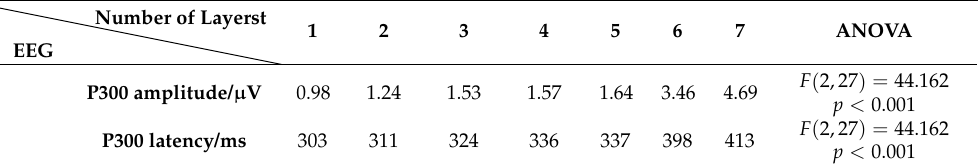
Figure 16. Change trend graph of subjects' eye movement data under different numbers of infor- mation layers.